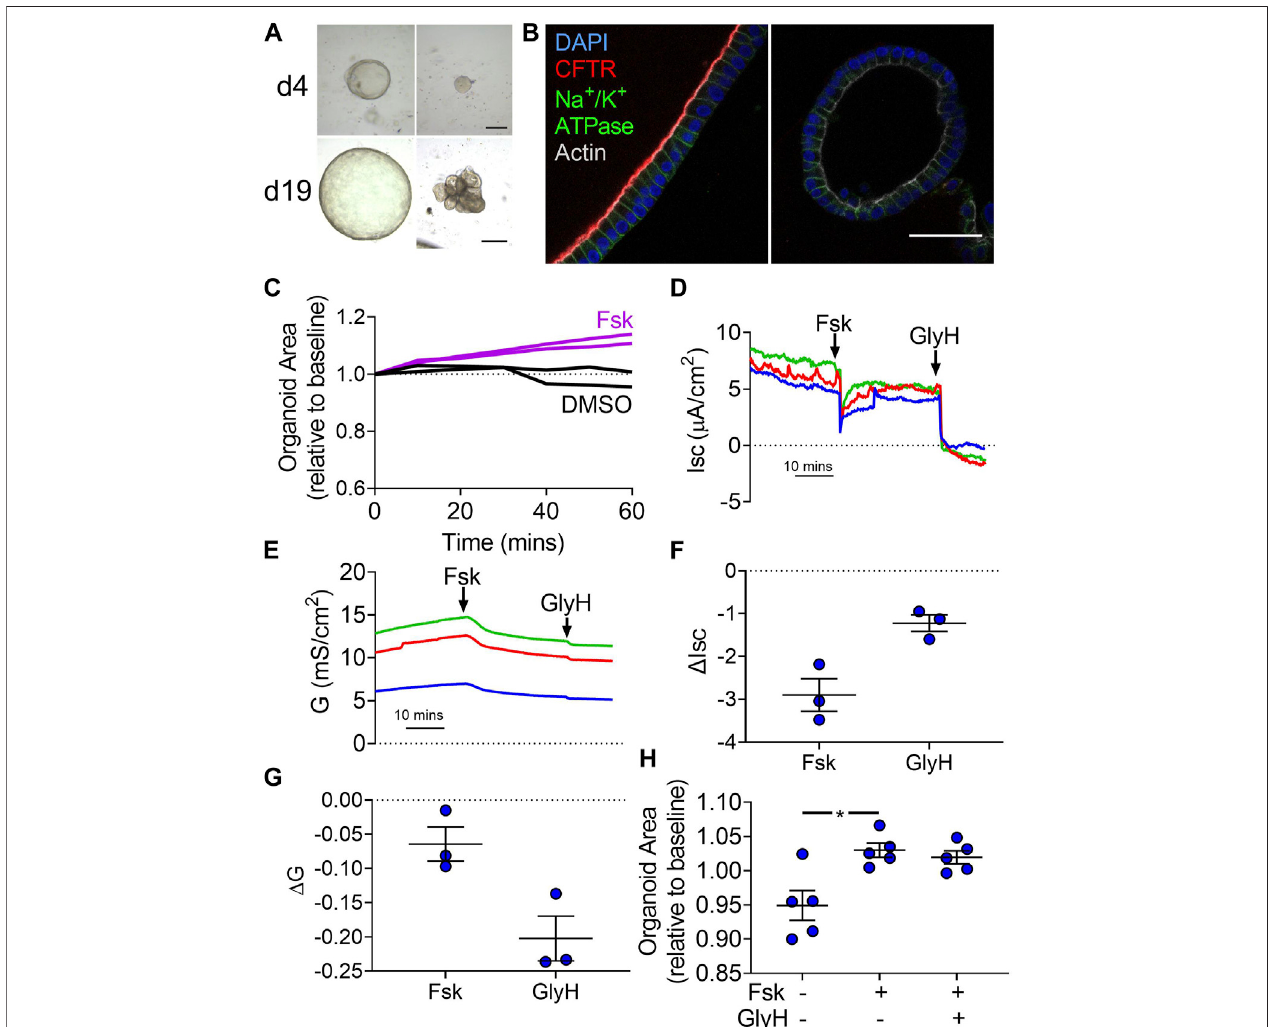
FIGURE 5 | Forskolin induces swelling of Δ F508/ Δ F508 organoids without electrophysiological changes in organoid-derived monolayers. (A) Representative bright fi eldimagesof Δ F508/ Δ F508 organoidsondays4(d4)and19(d19)ofculture(passage0).Someorganoidsdemonstratedmorphologylikethenon-CFdonors(left panels)whileotherorganoidsdemonstratedbuddingandlumenirregularities. (B) ApicalCFTRimmuno fl uorescence(red)waspresentinnon-CFdonors(leftpanel)while not present in the Δ F508/ Δ F508 organoids (right). Despite lack of CFTR expression, Δ F508/ Δ F508 demonstrated apical-basolateral polarity. Blue — DAPI. Green — Na + /K + -ATPase. Gray — Actin (scale bar = 50 µm). (C) CF organoid swelling with 10 µM forskolin (Fsk) or vehicle (DMSO) treatment. Data represent two experiments with different seedings of the CF donor. (D) Isc and (E) G traces of three different seedings (indicated by colors) in Krebs ’ /HCO 3 − solution. (F) Δ Isc and (G) Δ Gvaluesforthreedifferentseedings(Finalconcentration:Fsk=forskolin10 µM(apical),GlyH − 101=100 µM) (H) Non-CForganoidforskolin-inducedswellingafter 1 h pretreatment with eitherDMSO or GlyH. Each symbol representsaunique donor. Barsrepresentmean ±SEM. *indicates p -value < 0.05;one-wayANOVA with Dunnett correction for multiple